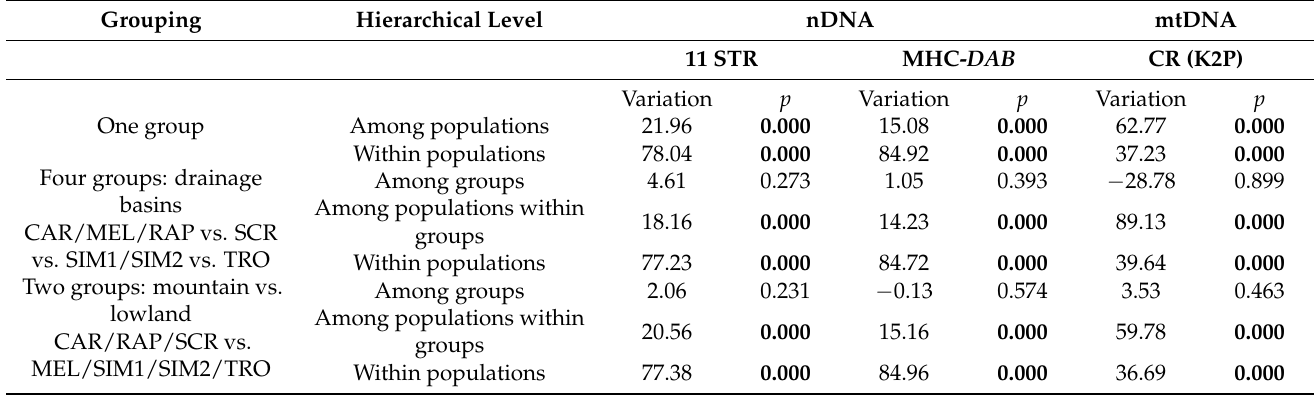
Table 3. AMOVA hierarchical analysis examining the partitioning of genetic variance of nuclear loci (STR and MHC- DAB ) and mitochondrial DNA Control Region (CR) according to different hypothesized structures: no structure (one group), drainage basins (four groups), mountain and lowland (two groups). The amount of variation (%) explained by differences among groups, among populations within groups, and within populations, along with the p -values (statistically significant values are in bold) are